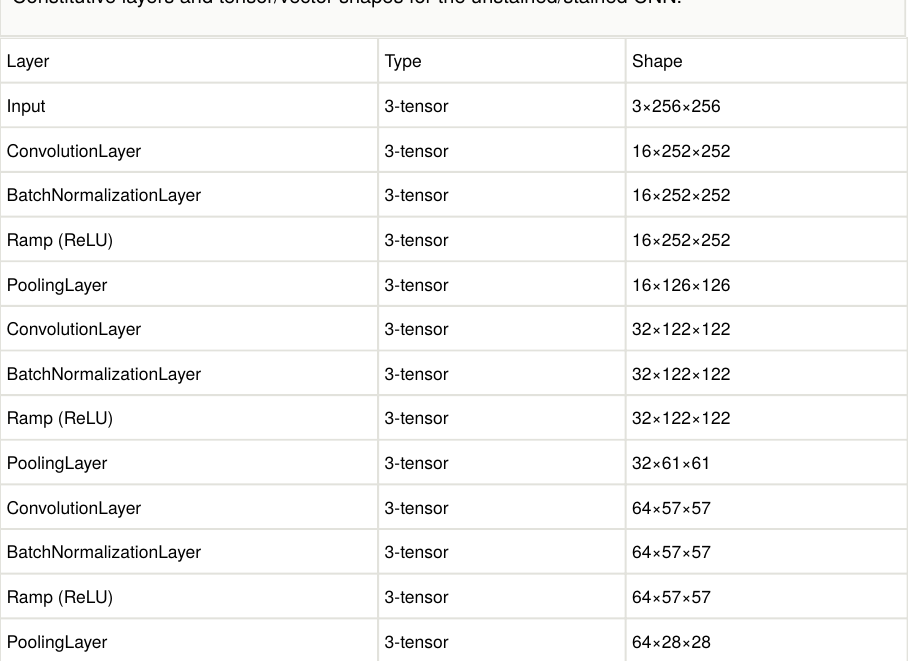
Constitutive layers and tensor/vector shapes for the unstained/stained